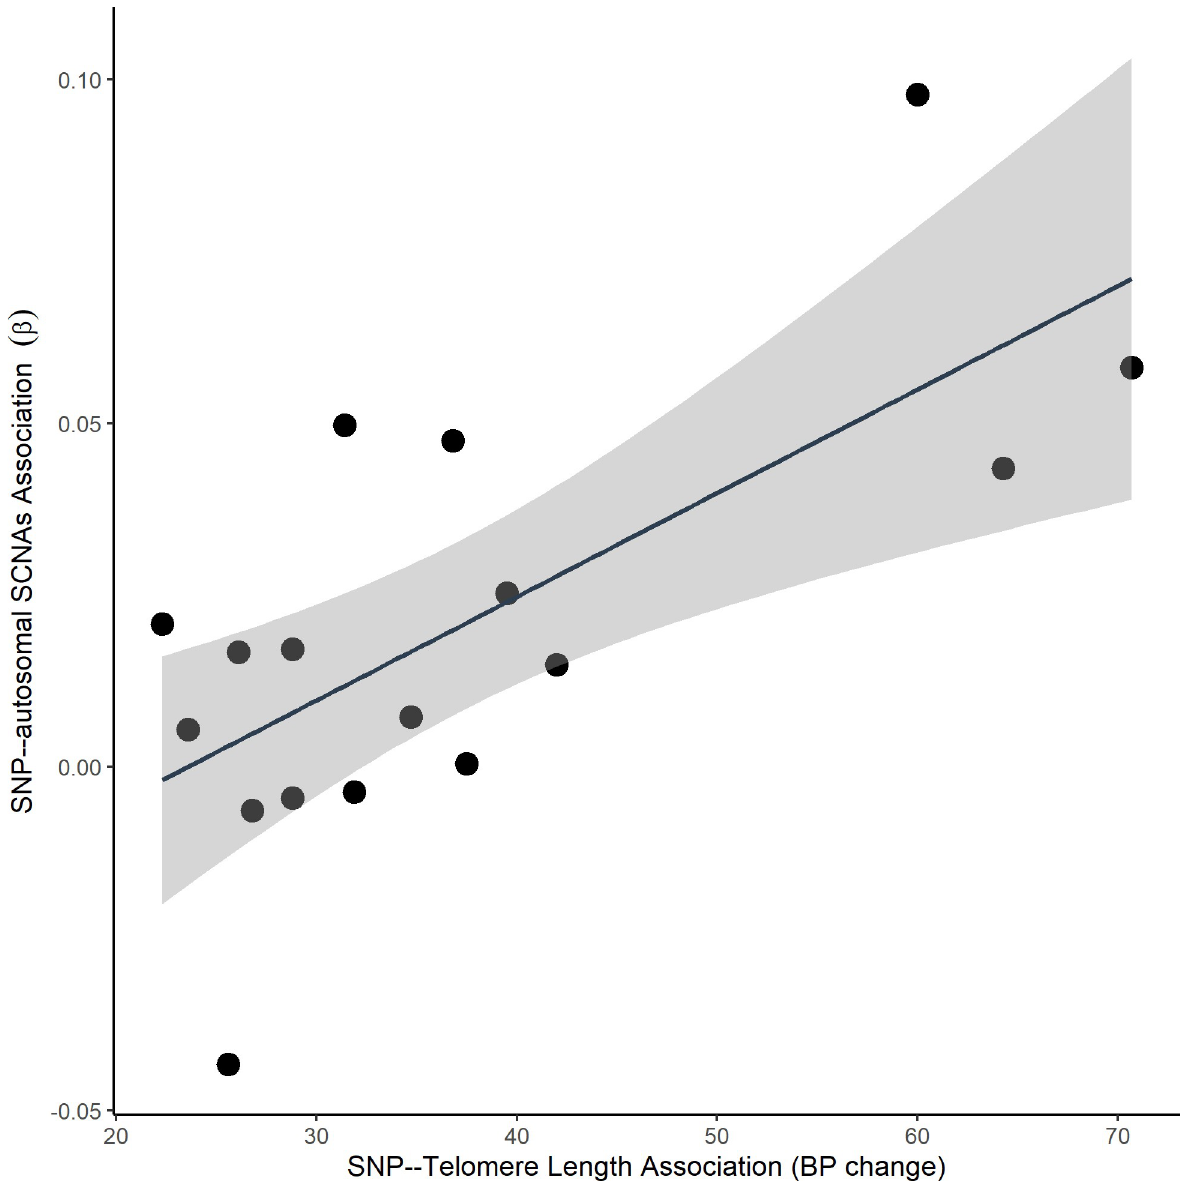
Fig 1. The effect of each variant on genetically-predicted telomere length and autosomal SCNAs. Estimates for the single nucleotide polymorphism (SNP)—telomere and SNP—autosomal SCNAs associations are presented in S4 Table . Only variants with minor allele frequency greater than 5% are